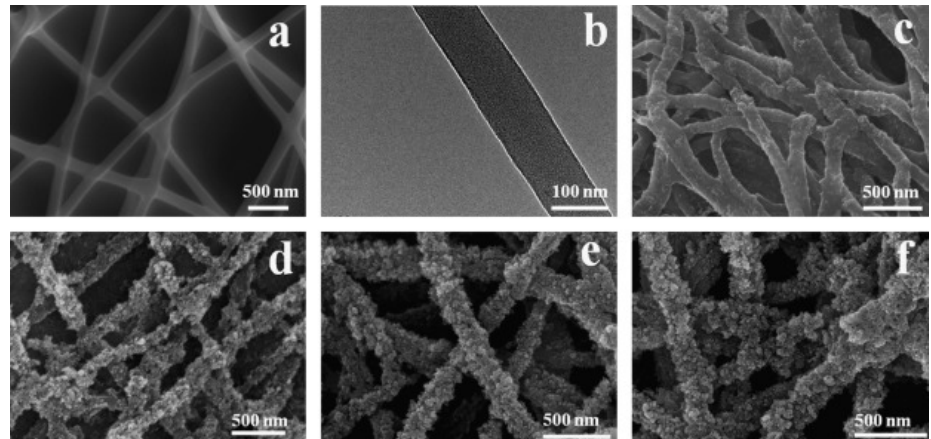
Figure 11. ( a ) SEM image of electrospun nanofibers of natural cotton cellulose, ( b ) TEM image of nature cotton cellulose nanofibers, and ( c – f ) SEM images of CC/CdS-5, CC/CdS-10, and CC/CdS-20, CC/CdS-30. (Reprinted from the work of Liu et al. [41]. Copyright 2015, with permission from Else- vier).